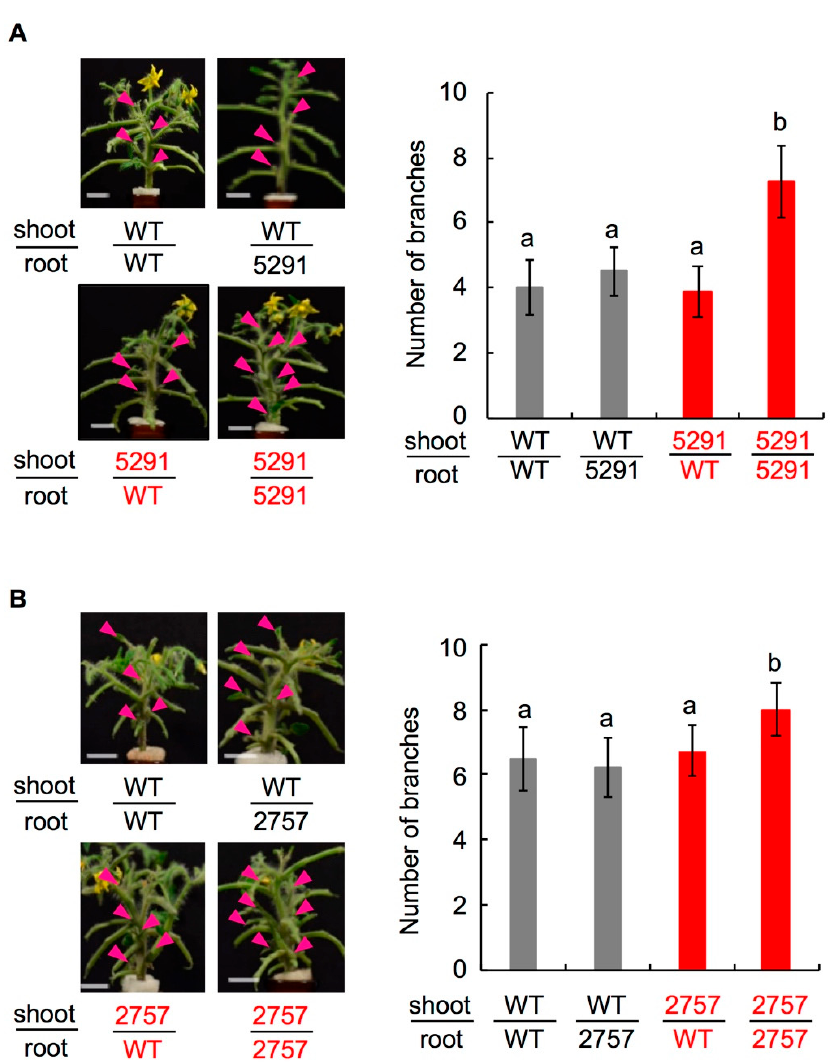
Figure 5. Effect of endogenous SL on branching. Photographs show 60-day-old plants grafted using scions and rootstocks from WT, and ( A ) line 5291 or ( B ) line 2757 as indicated. Arrowheads show outgrowing axillary buds. Branches were counted for 50 days. Error bars, S.D. Different lowercase letters show significant difference by Tukey’s multiple comparison test ( p < 0.05).